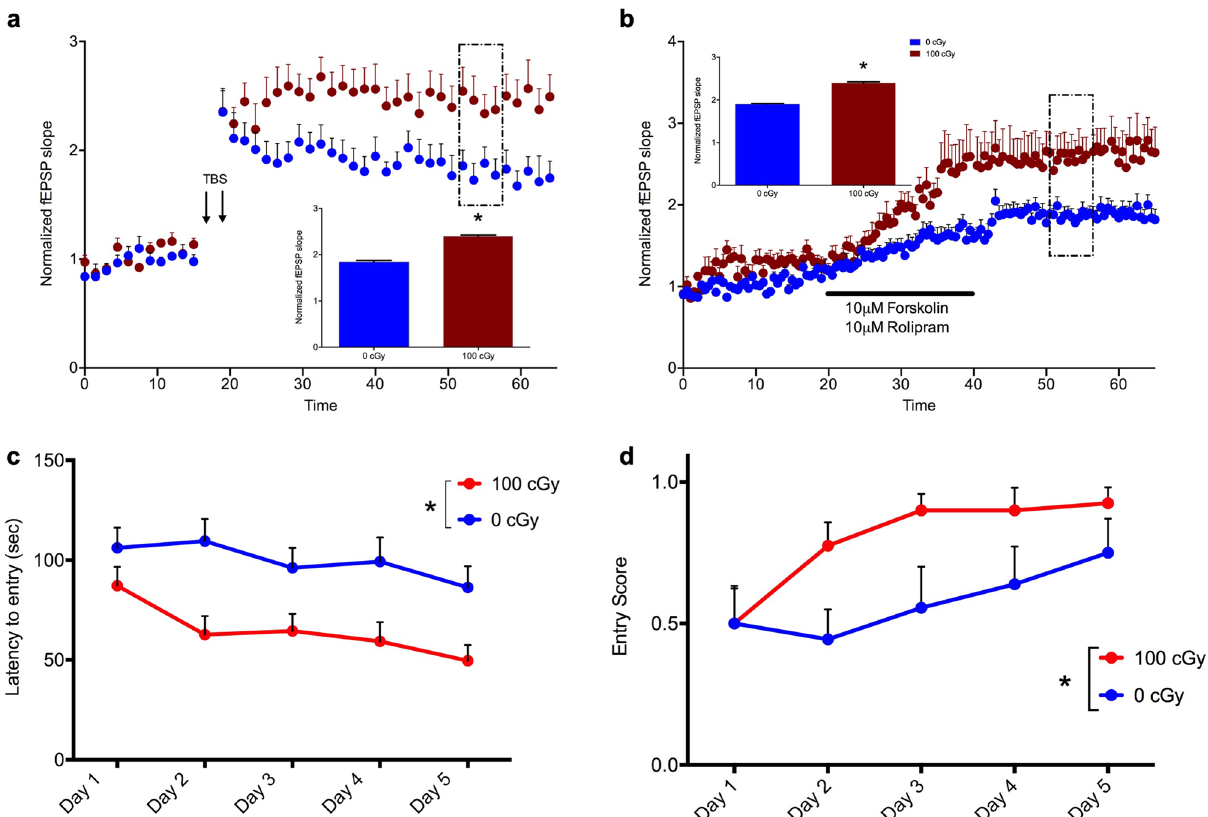
Figure 5. Enhancements in Schaffer collateral-CA1 LTP and spatial learning 20 months after exposure to 56 Fe particle radiation ( a ) Time course and magnitude (inset bar graph) of stimulus-evoked LTP in slices from male mice exposed to 100 cGy radiation, compared to sham-irradiated controls (0 cGy). After a 15 min baseline, LTP was elicited by two TBS stimulus trains (arrows), and the magnitude of LTP between 35–40 min post TBS or bath application (perforated box) compared across doses. * P < 0.0001, Two-tailed t test, n = 12–16 slices per dose. ( b ) Time course and magnitude (inset bar graph) of chemically-evoked LTP elicited by bath application (bar) of 10 µM forskolin plus 10 µM rolipram to slices from male mice exposed to 100 cGy radiation compared to sham- irradiated controls (0 cGy). Each point represents mean ± SEM. * P < 0.0001, Two-tailed t test, n = 12–16 slices per dose. ( c , d ) Learning curves depicting ( c ) latency for entry into an escape box in the Barnes Maze, Two-way RM ANOVA, dose : F(1,90) = 30.73, P < 0.0001; trial : F(4,90) = 2.22, P = 0.073; interaction : F(4,90) = 0.553, P = 0.698, Tukey’s post hoc test: Day 2, 0 cGy vs. 100 cGy, P = 0.006, Day 4, 0 cGy vs. 100 cGy, P = 0.027, or (d) the fraction of successful trials per day, Two-way RM ANOVA, dose: F(1,90) = 10.51, P = 0.002, trial : F(4,90) = 3.06, P = 0.020; interaction : F(4,90) = 0.849, P = 0.497, (Tukey’s post hoc test did not reveal significant within treatment effect), are shown for male mice exposed to 100 cGy radiation compared to sham-irradiated controls (0 cGy). Each point represents mean latency ± sem. * P < 0.05, n = 10 mice per